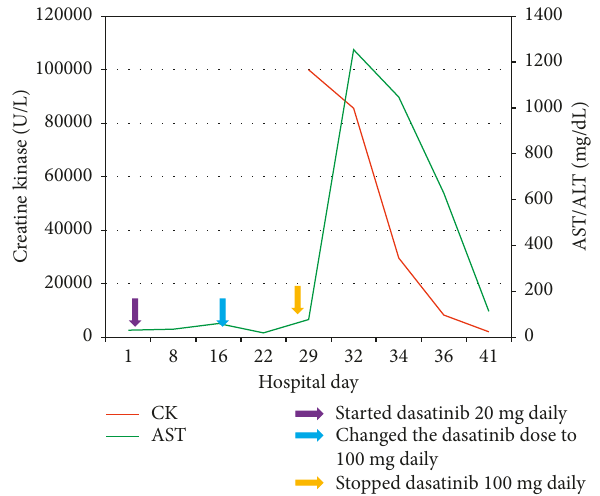
Figure 1: Trend in patient serum creatine kinase (U/L) and serum aspartate aminotransferase (AST) from hospital day 1 to hospital day